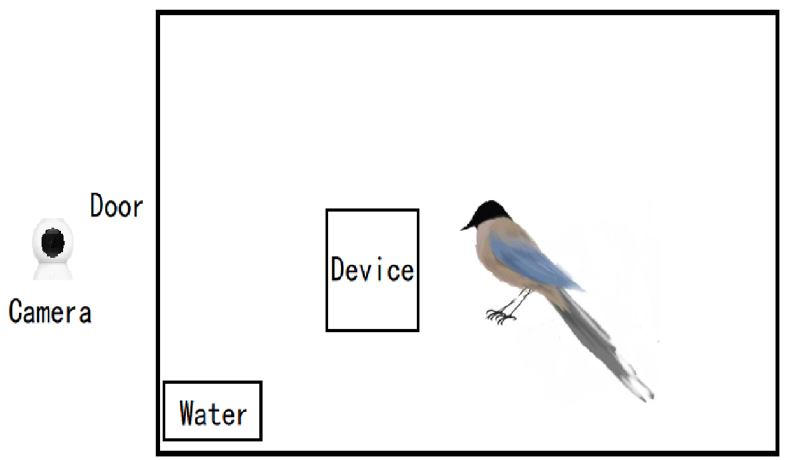
Figure 3. Schematic of experimental